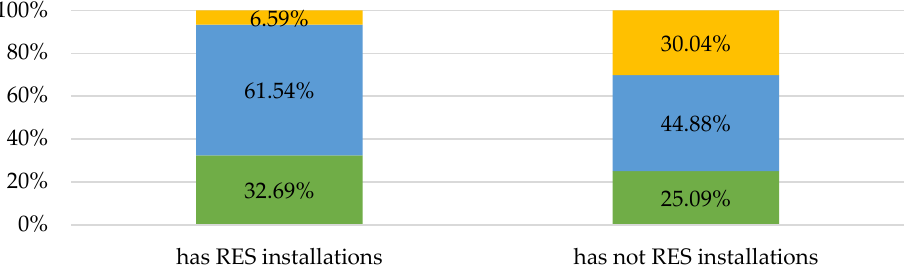
Figure 11. State of a residential building in terms of having RES installation.